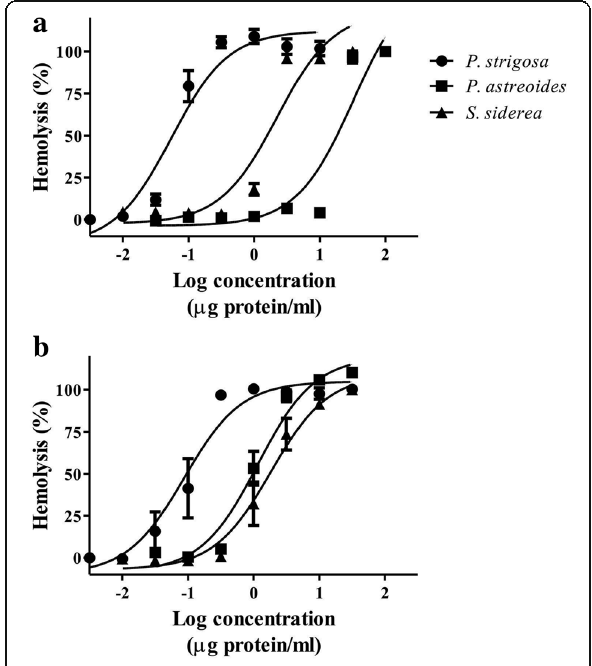
Fig. 2 Log-concentration response curves showing the hemolytic activity of the extracts in ( a ) rat and ( b ) human